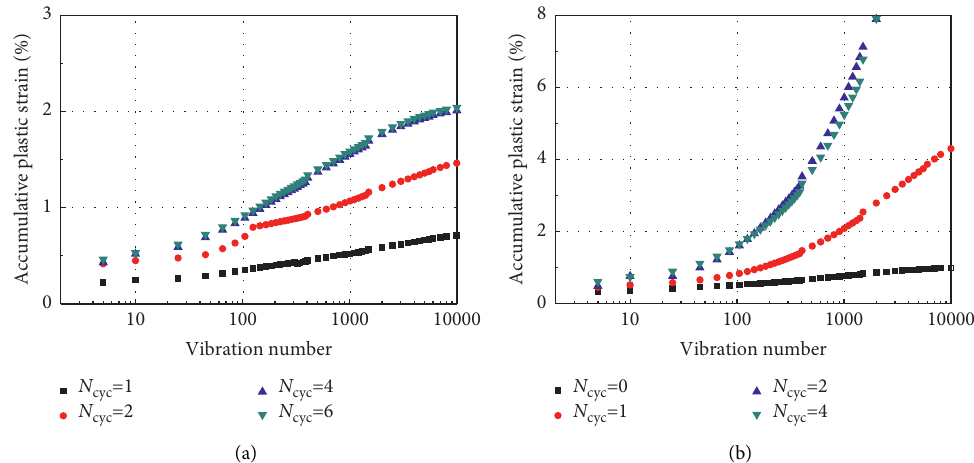
Figure 4: Relationship between the accumulative plastic strain and vibration numbers under different number of freeze-thaw cycles. (a) σ d � 200kPa. (b) σ d � 300kPa.